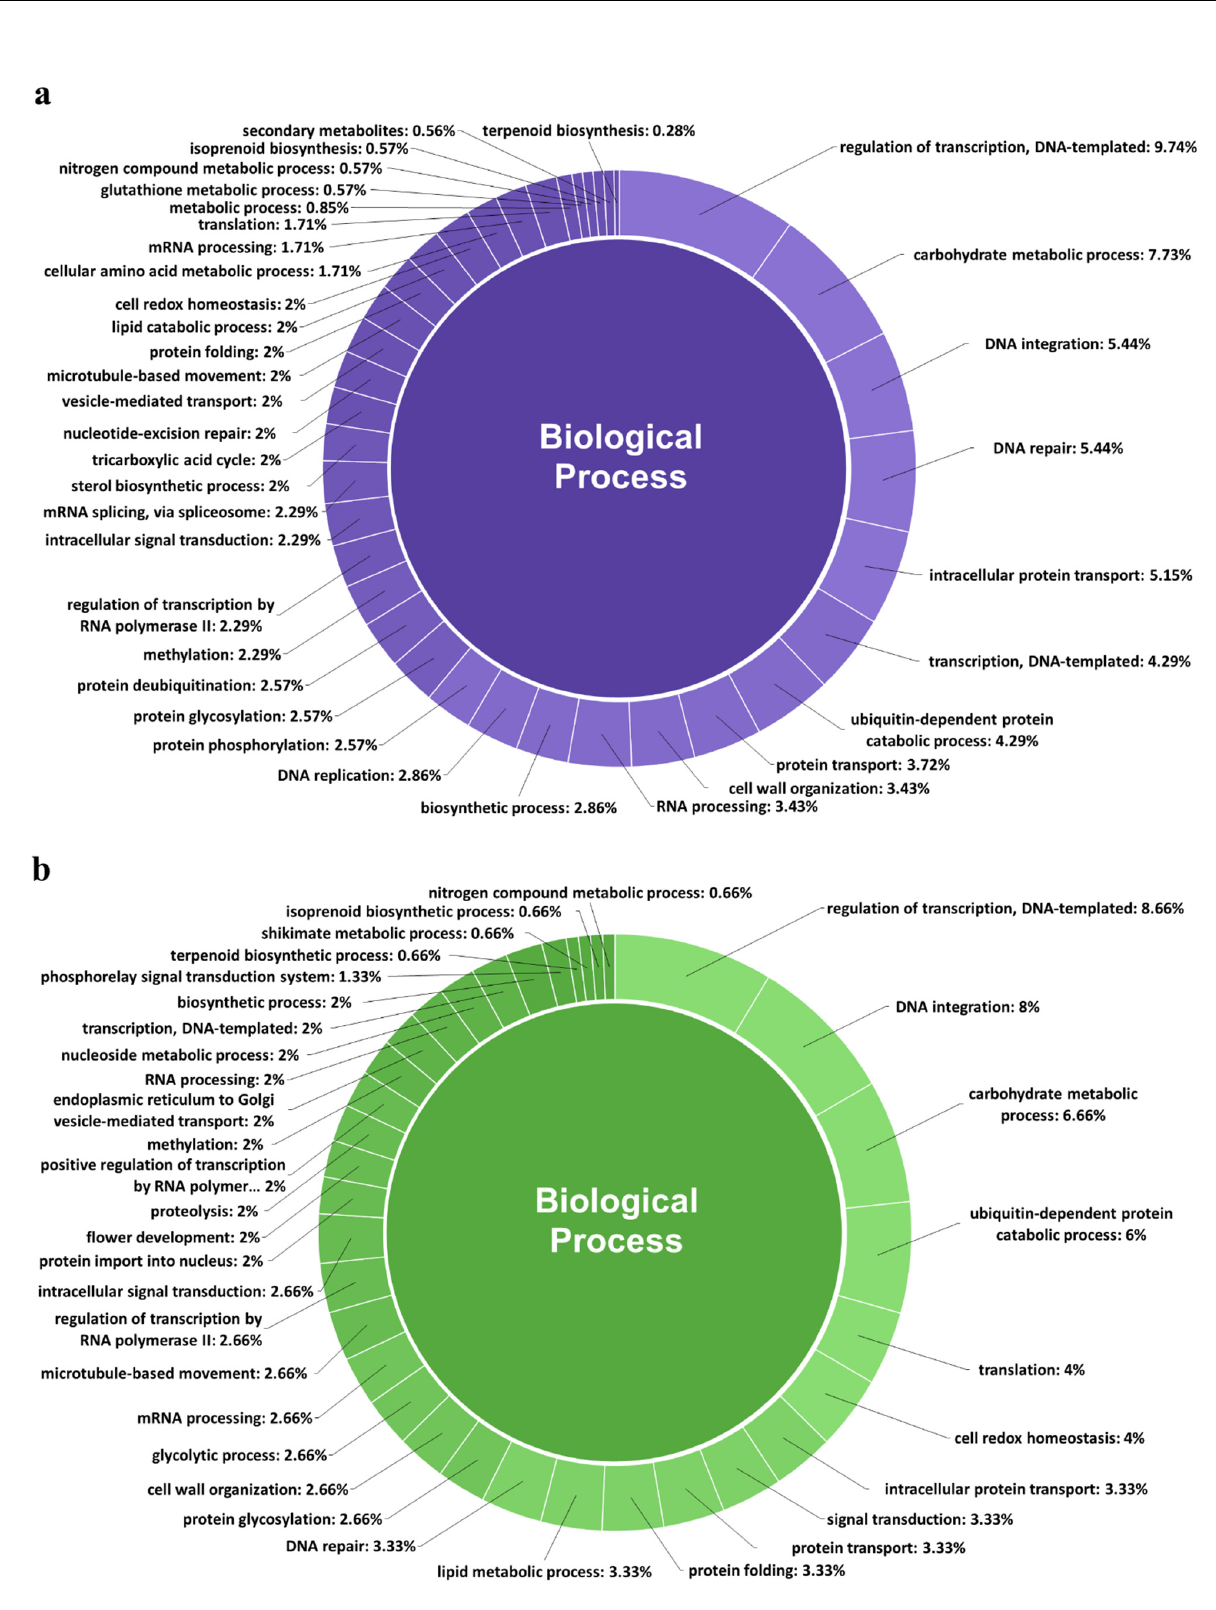
Figure 4. Biological Process categories of the GO analysis of the potential target genes of both conserved ( a ) and novel ( b ) miRNAs from M. koenigii.